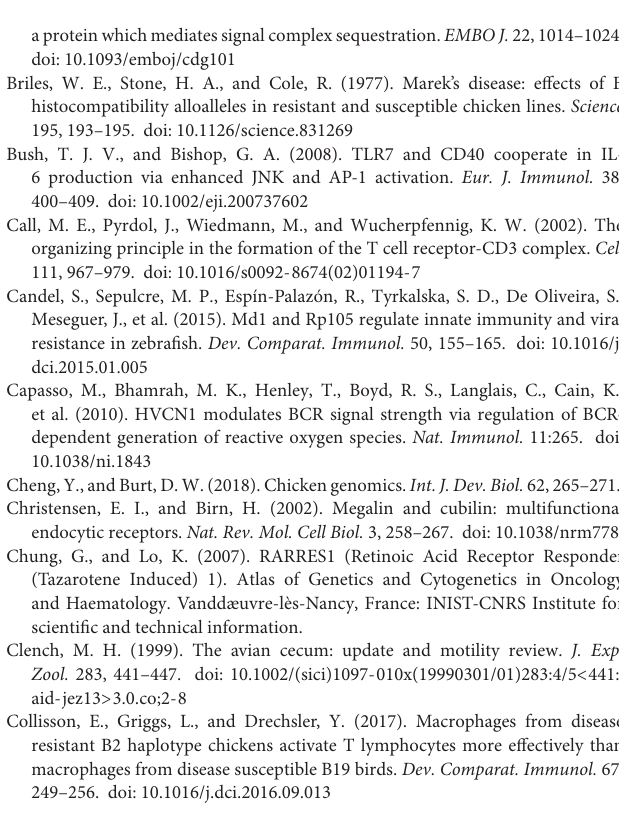
WebGestalt (GO) results – DOWNREGULATED DEGs